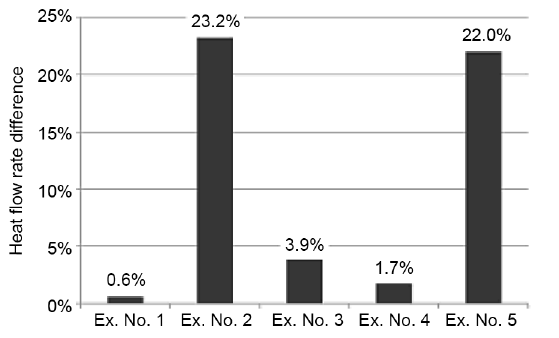
Fig. 4. Average heat flow rate differences through the cell roof constructions during twenty-four